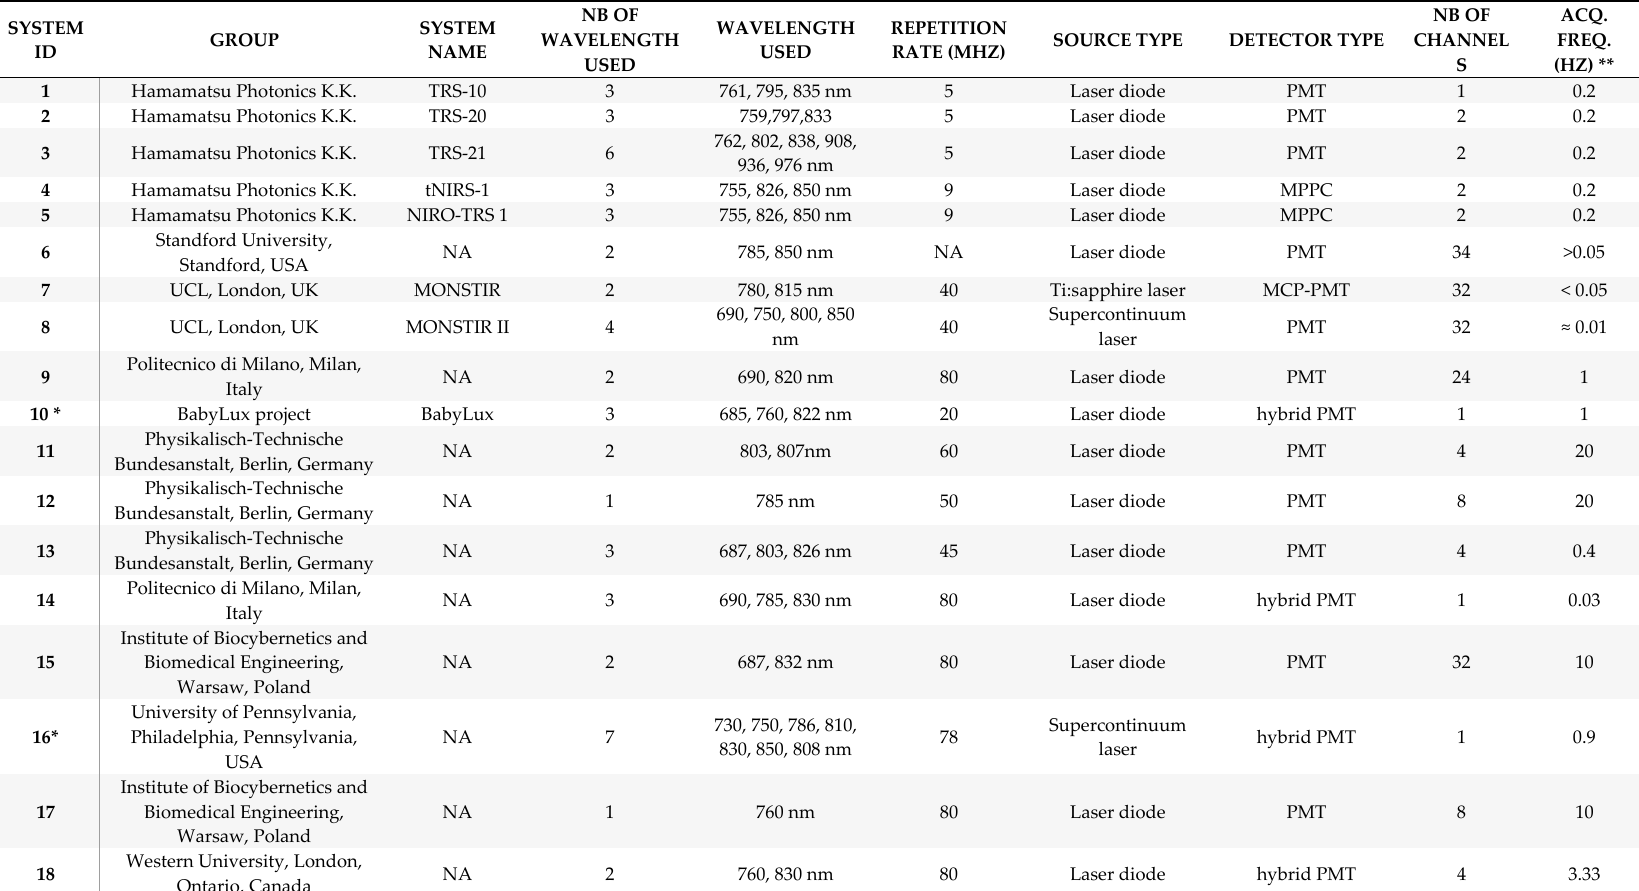
Table 2. List of the system used in the publication reviewed, with their principle characteristics.